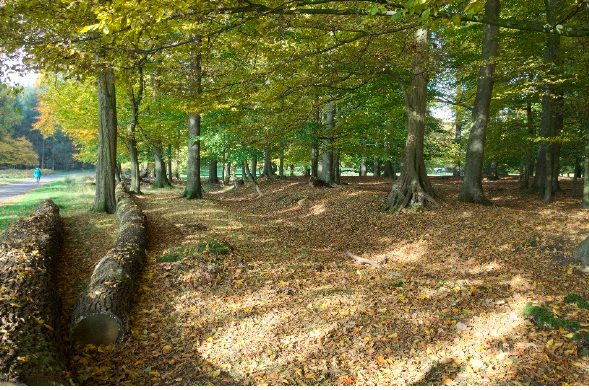
Figure 4 . Ridge and Furrow area in Dülmen.